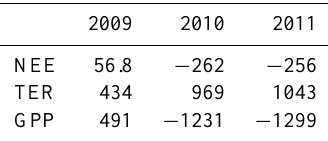
Table 2. The estimated annual CO 2 balances of the reed canary grass cultivation. Annual values of net ecosystem CO 2 exchange (NEE), total ecosystem respiration (TER) and gross primary pro- duction (GPP) are shown in gCm − 2 . Negative values stand for up- take and positive for emission to the atmosphere. Note that 2009 is not a full year (23 July to 31